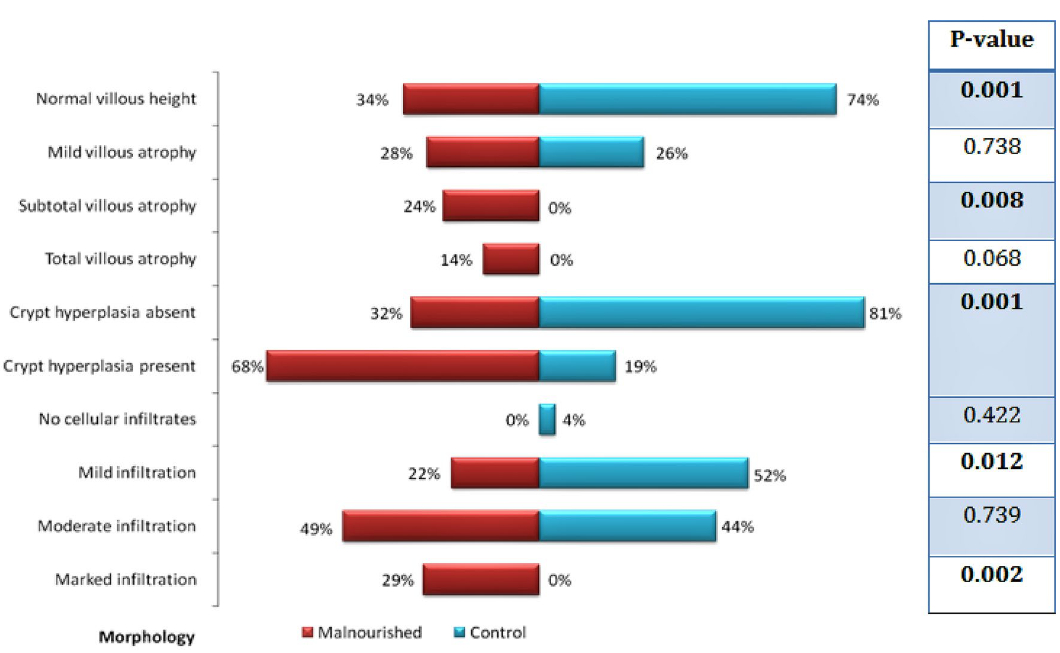
Figure 4. Comparison of histological features between malnourished and healthy adults. P-value Significance level. Tests used ; Pearson’s Chi-Square test, Fisher’s exact